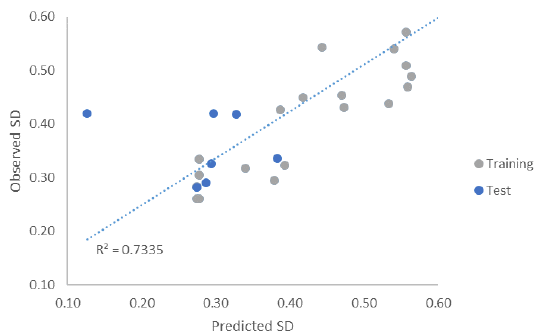
Figure 6. Observed vs. predicted graph for standard deviation of droplet size for the training set used for model construction and test set used for model testing.